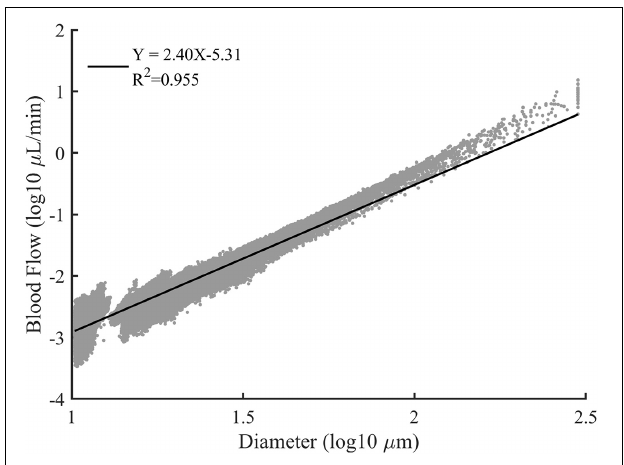
FIGURE 7 | The log-log plot of the blood flow rate versus the vessel diameter for all constructed vascular trees. The solid line is the best fit result of linear